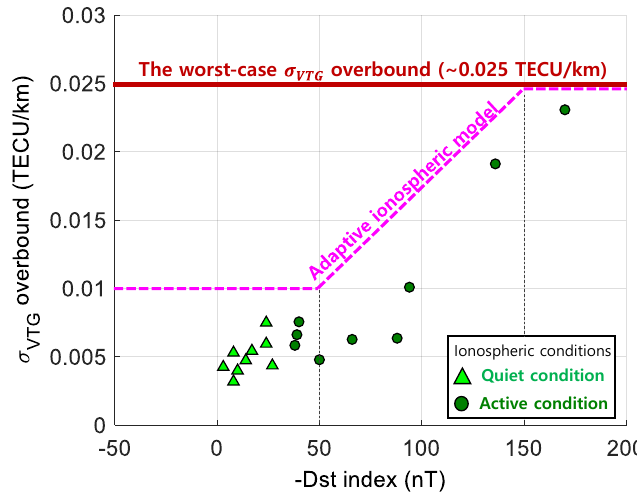
Figure 7. An example of the adaptive ionospheric model using the relationship between Dst and σ VTG_overbound .